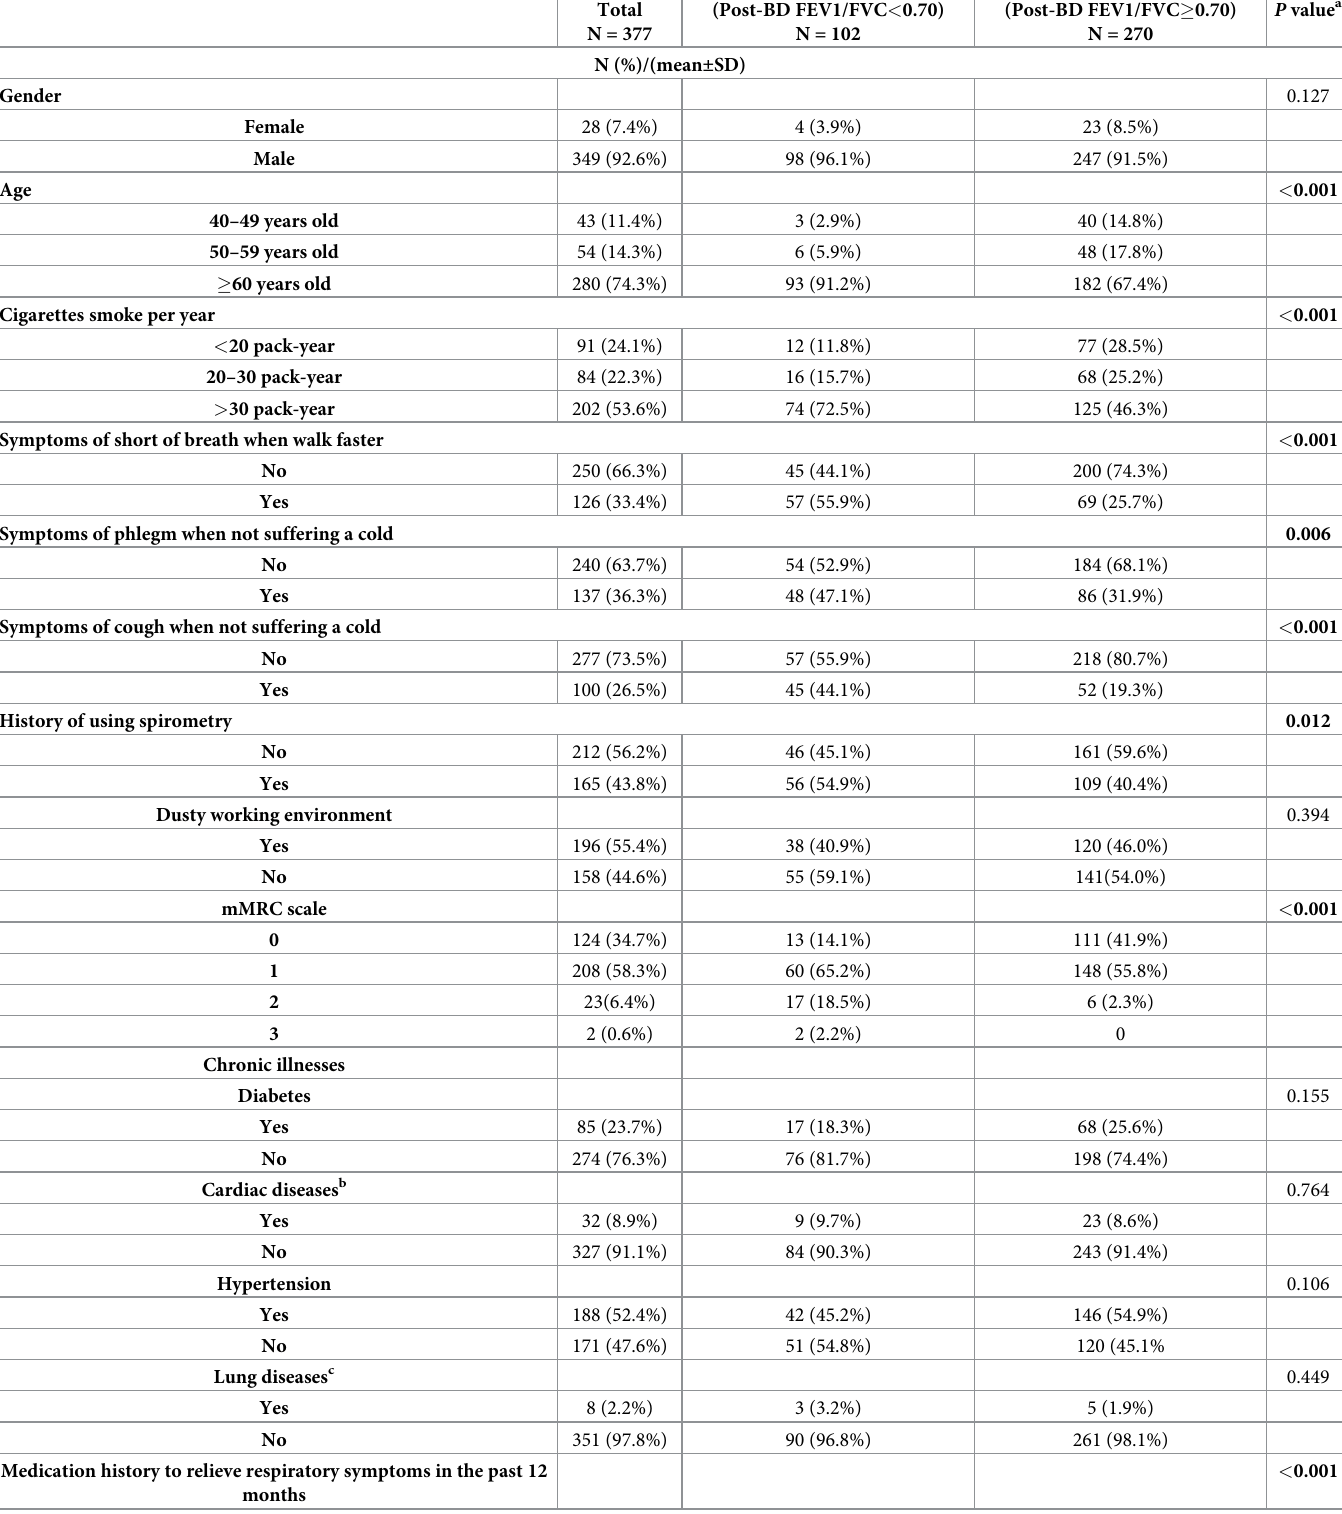
Table 1. Participant demographic and clinical characteristics by patients with COPD and patients without COPD (N =